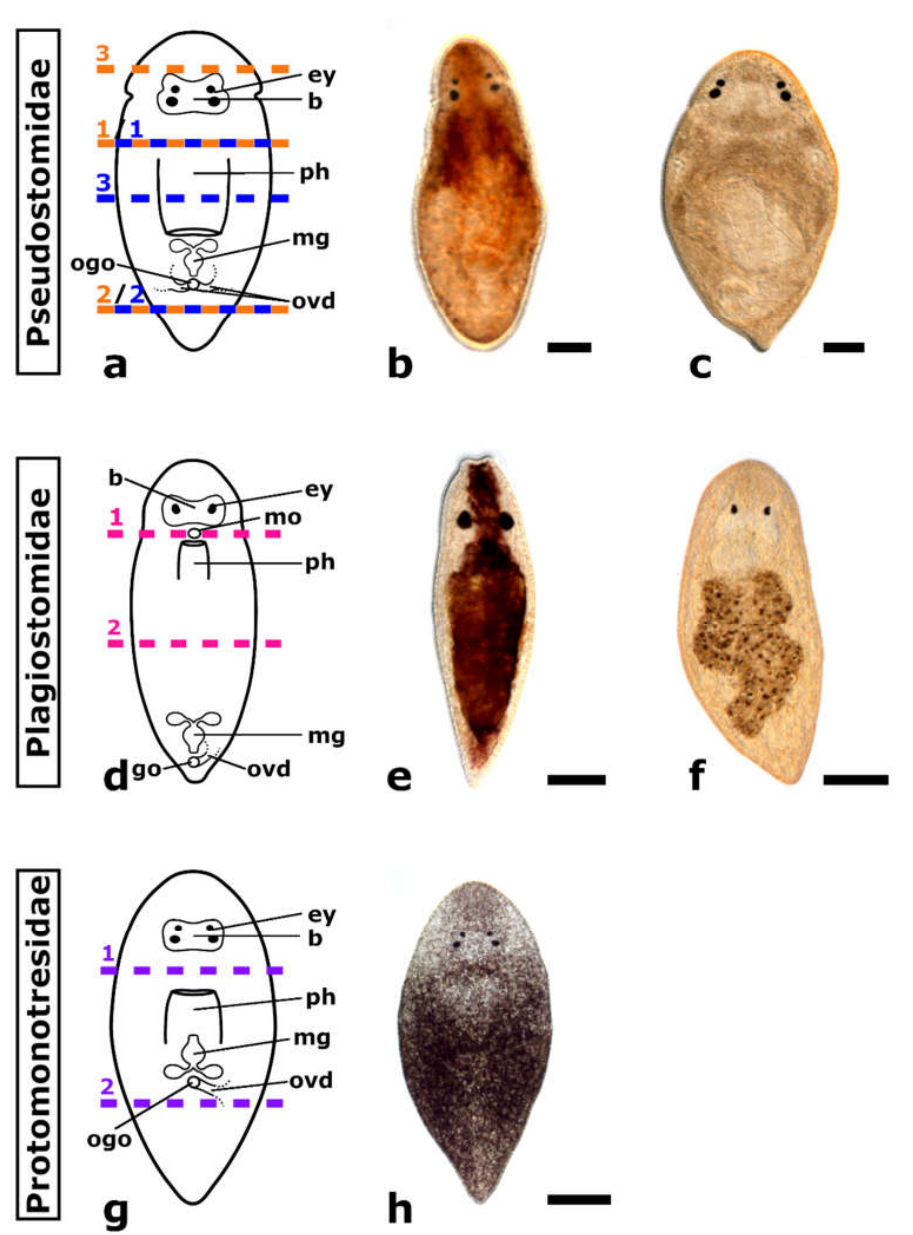
Figure 2. The five prolecithophoran species studied in detail belonging to three different families (Pseudostomidae, Plagiostomidae, Protomonotresidae). Schematic drawings of a Pseudostomidae ( a ), a Plagisostomidae ( d ) and a Protomonostresidae ( g ), showing the different amputation levels. The amputation levels used for each species are indicated in a different colour: Monoophorum striatum in orange, Cylindrostoma monotrochum in blue, Vorticeros auriculatum and Plagiostomum girardi in pink, and Protomonostresidae sp. in purple. Differential contrast images of living squeeze-prepped animals of Monoophorum striatum ( b ), Cylindrostoma monotrochum ( c ), Vorticeros auriculatum ( e ), Plagiostomum girardi ( f ), and Protomonostresidae sp. ( h ). Abbreviations: b, brain; ey, eye; go, genital opening; mg, male genital organ; mo, mouth opening; ogo, orogenital opening; ovd oviduct; ph, pharynx. Scale bars: 100 µm in ( b ), ( c ) and f; 200 µm in e ) and ( h ).